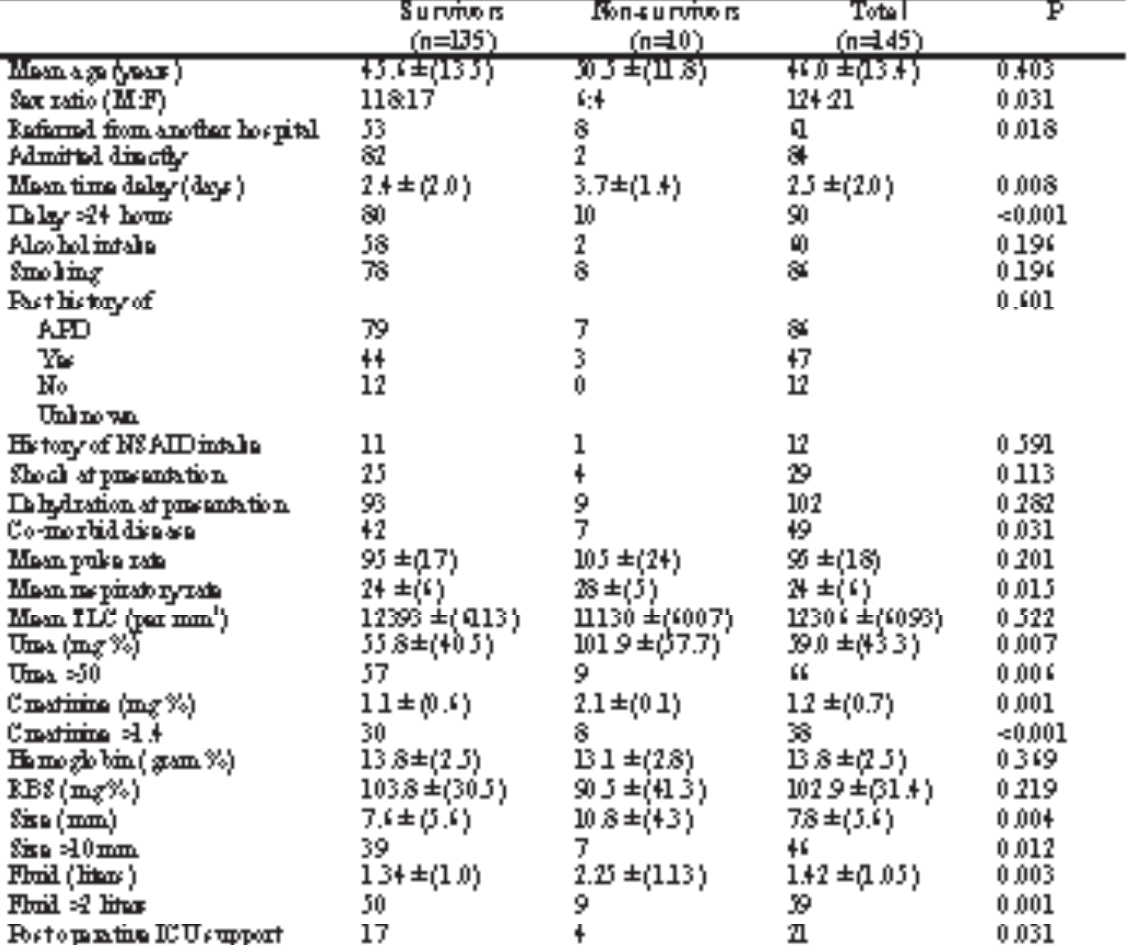
APD, acid peptic disease; NSAID, non steroidal anti-inflammatory drugs; RBS, random blood sugar, TLC, total leukocyte